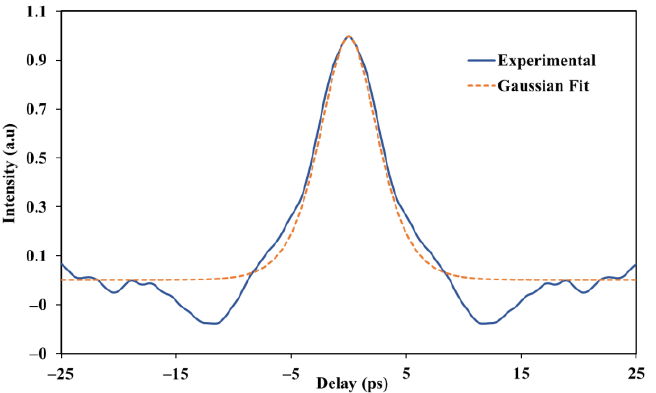
Figure 8. Autocorrelation output pulse trace at 175.85 mW pump power with time-span of 50 ps.